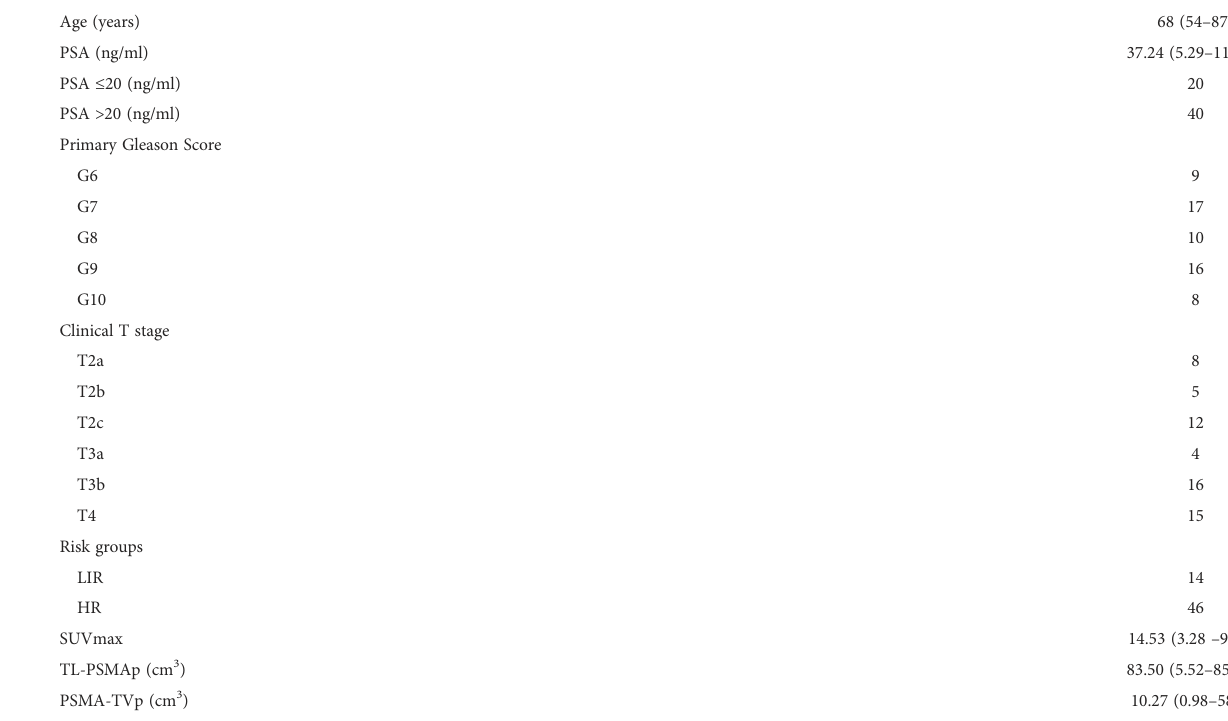
TABLE 1 Clinical characteristics and primary tumor semi-quantitative PSMA-PET parameters. Patients